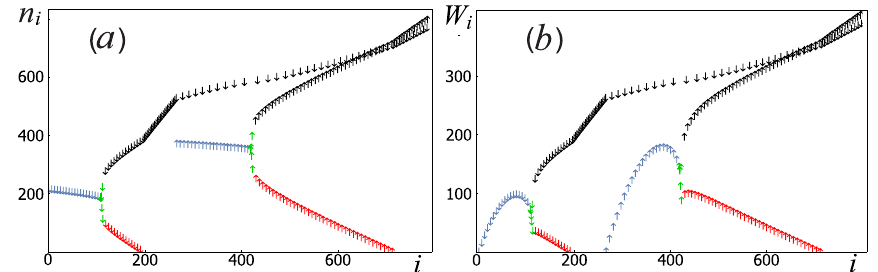
2 (The probability ¯ h 2